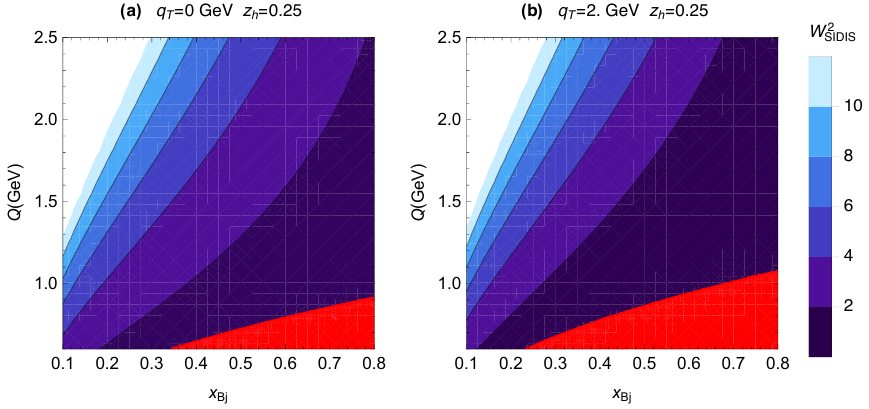
Figure 9 . Plots (a){(b) show W 2 , eq. (5.1), for q T = 0 and q T = 2 : 0 GeV respectively for the SIDIS case of a produced pion. Here z h = 0 : 25 in each case. The red region is kinematically forbidden. Near to the kinematically forbidden region, it is to be expected that a clear separation into regions along the lines of (cid:12)gure 8 will break down. The classi(cid:12)cation according to the sizes of R 0 - R 3 is cleaner at larger Q and with small but (cid:12)xed x Bj . Note that the corresponding plots for a heavier (cid:12)nal state hadron have a larger forbidden region.